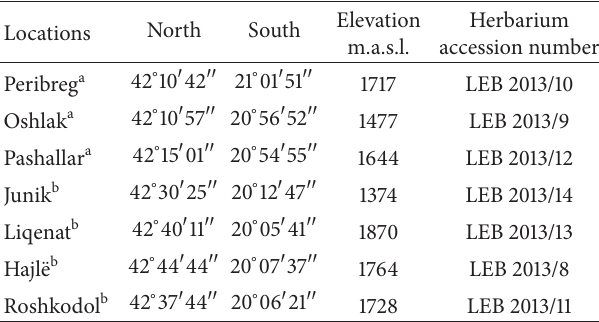
Table 1: Basic characterization of the sites from where the plant materials of Pinus peuce populations were